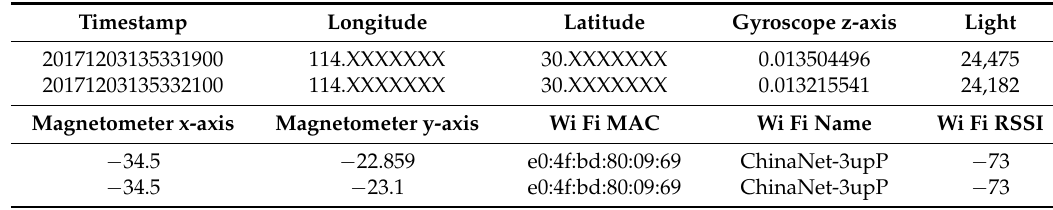
Table 4. Example of experimental data